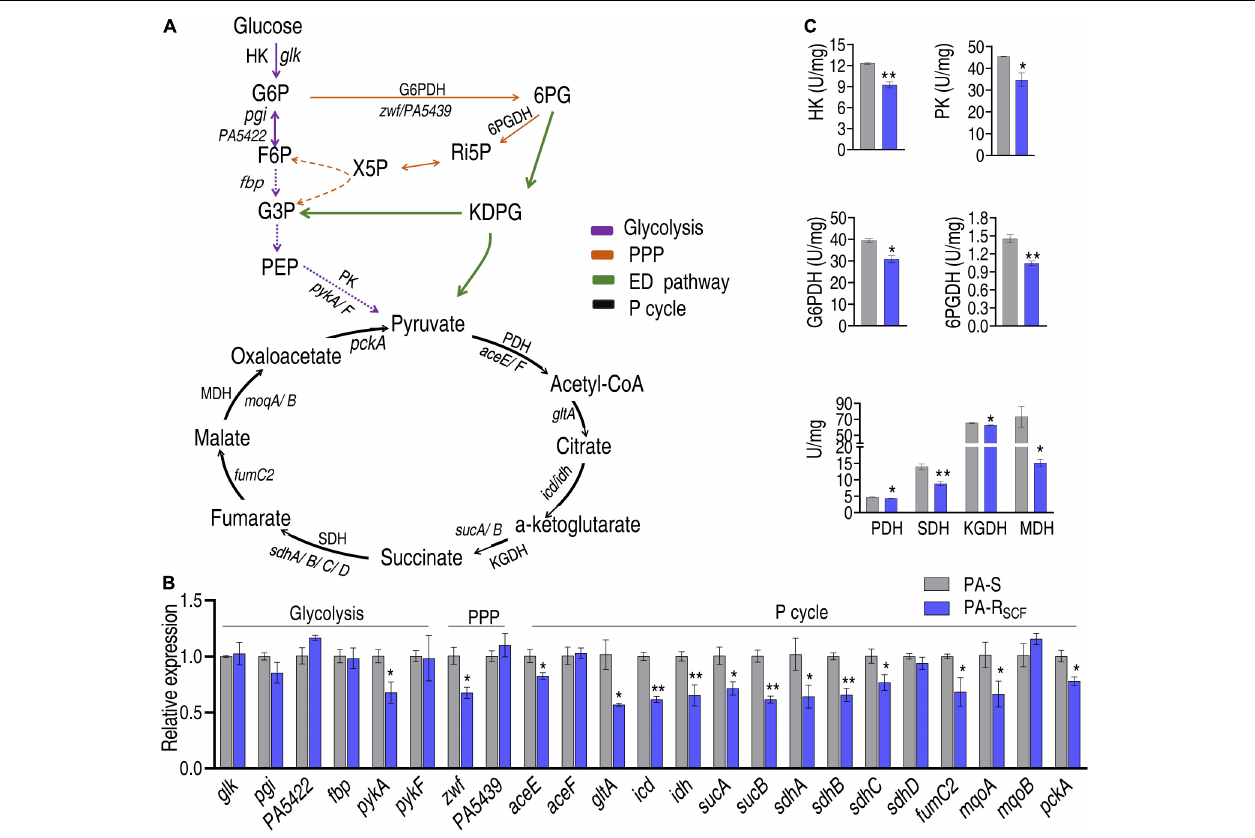
FIGURE 5 | Validation of the depressed central carbon metabolism. (A) Map showing that the composition of central carbon metabolism includes glycolysis, PPP, ED pathway, and P cycle. G6P, glucose-6-phosphate; F6P, fructose-6-phosphate; 6PG, 6-phosphogluconate; KDPG, 2-keto-3-deoxy-6-phosphogluconate; Ri5P, ribulose-5-phosphate; X5P, xylulose-5-phosphate; G3P, glyceraldehyde-3-phosphate; PEP, phosphoenolpyruvate; HK, hexokinase; PK, pyruvate kinase; PDH, pyruvate dehydrogenase; KGDH, alpha-ketoglutarate dehydrogenase; SDH, succinate dehydrogenase; MDH, malate dehydrogenase; G6PDH, glucose 6-phsophate dehydrogenase; 6PGDH, 6-phosphogluconate dehydrogenase. Solid lines represent single-step reaction and dashed lines represent multistep reaction. Arrows indicate the direction of the reaction. (B) qRT-PCR for expression of key genes in glycolysis, PPP, and P cycle. (C) Activity of enzymes in glycolysis, PPP, and P cycle. Results are displayed as mean ± SEM and three biological repeats are performed. Significant differences are identified. * p < 0.05 and ** p <